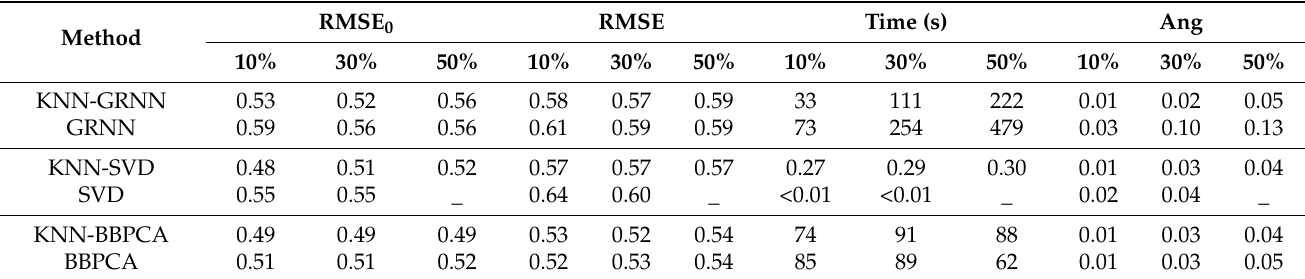
Table 2. Comparison of single and composite